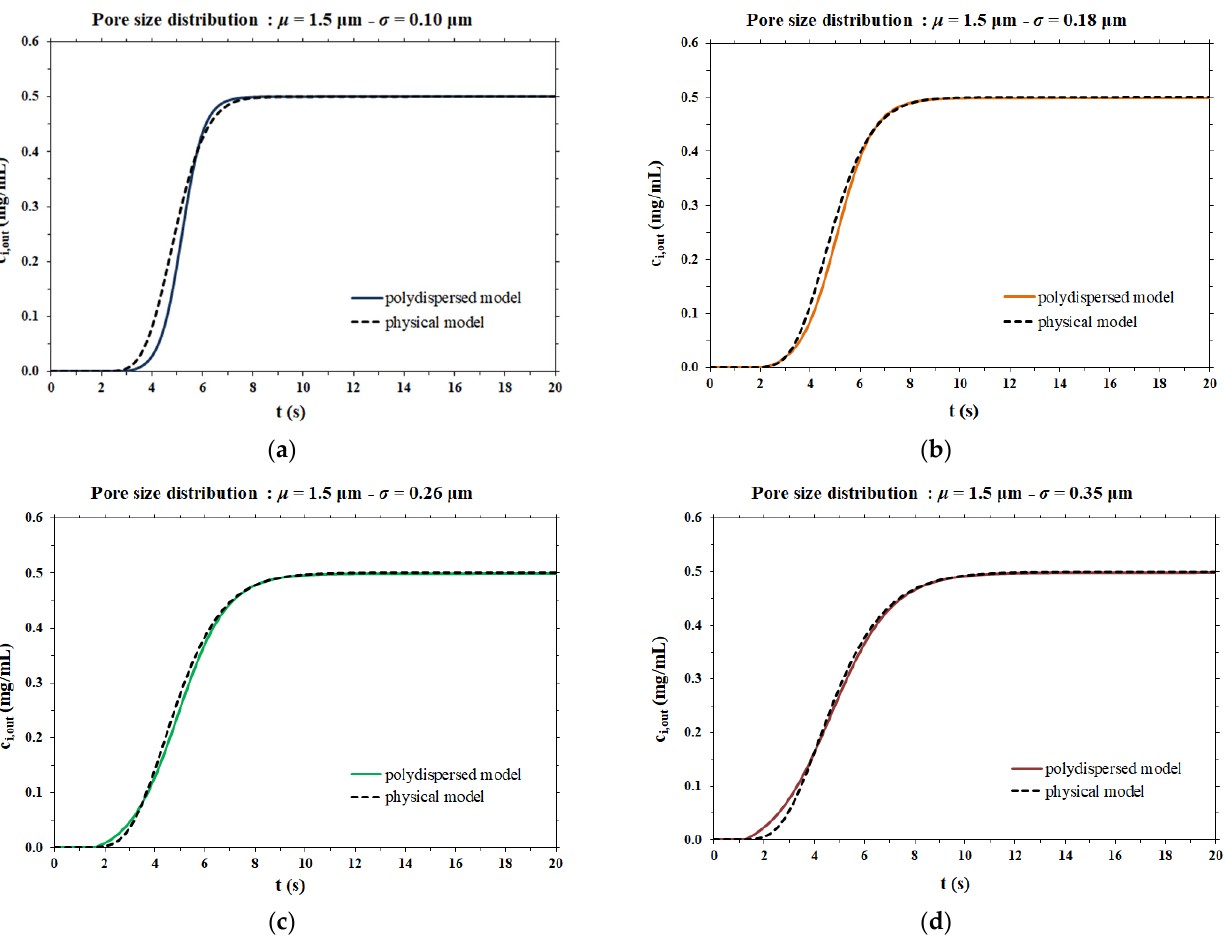
Figure 6. Comparison between the model proposed in this work and the physical model for different pore size distributions; ( a ) µ = 1.5 μ m and σ = 0.10 μ m; ( b ) µ = 1.5 μ m and σ = 0.18 μ m; ( c ) µ = 1.5 μ m and σ = 0.26 μ m; ( d ) µ = 1.5 μ m and σ = 0.35 μ m.